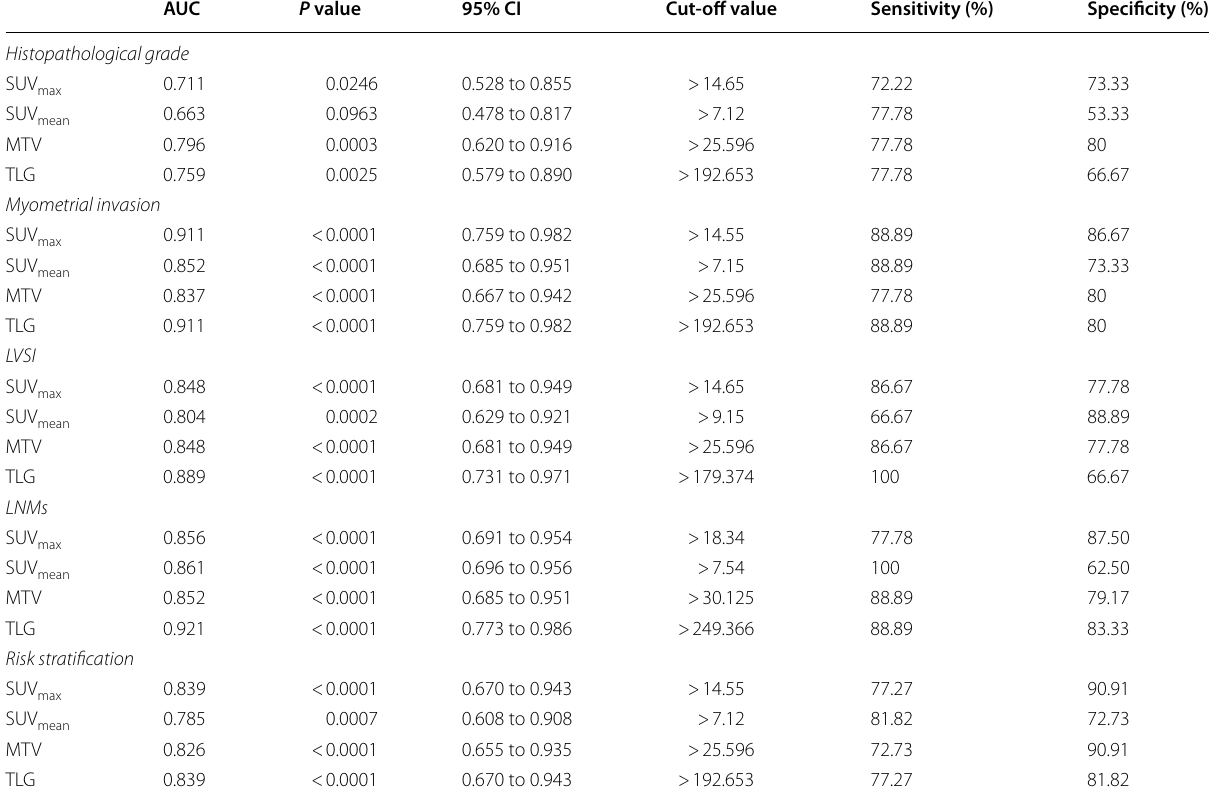
AUC, Area Under the Curve, LVSI, Lymph-vascular space invasion, LNMs, Lymph nodes metastases